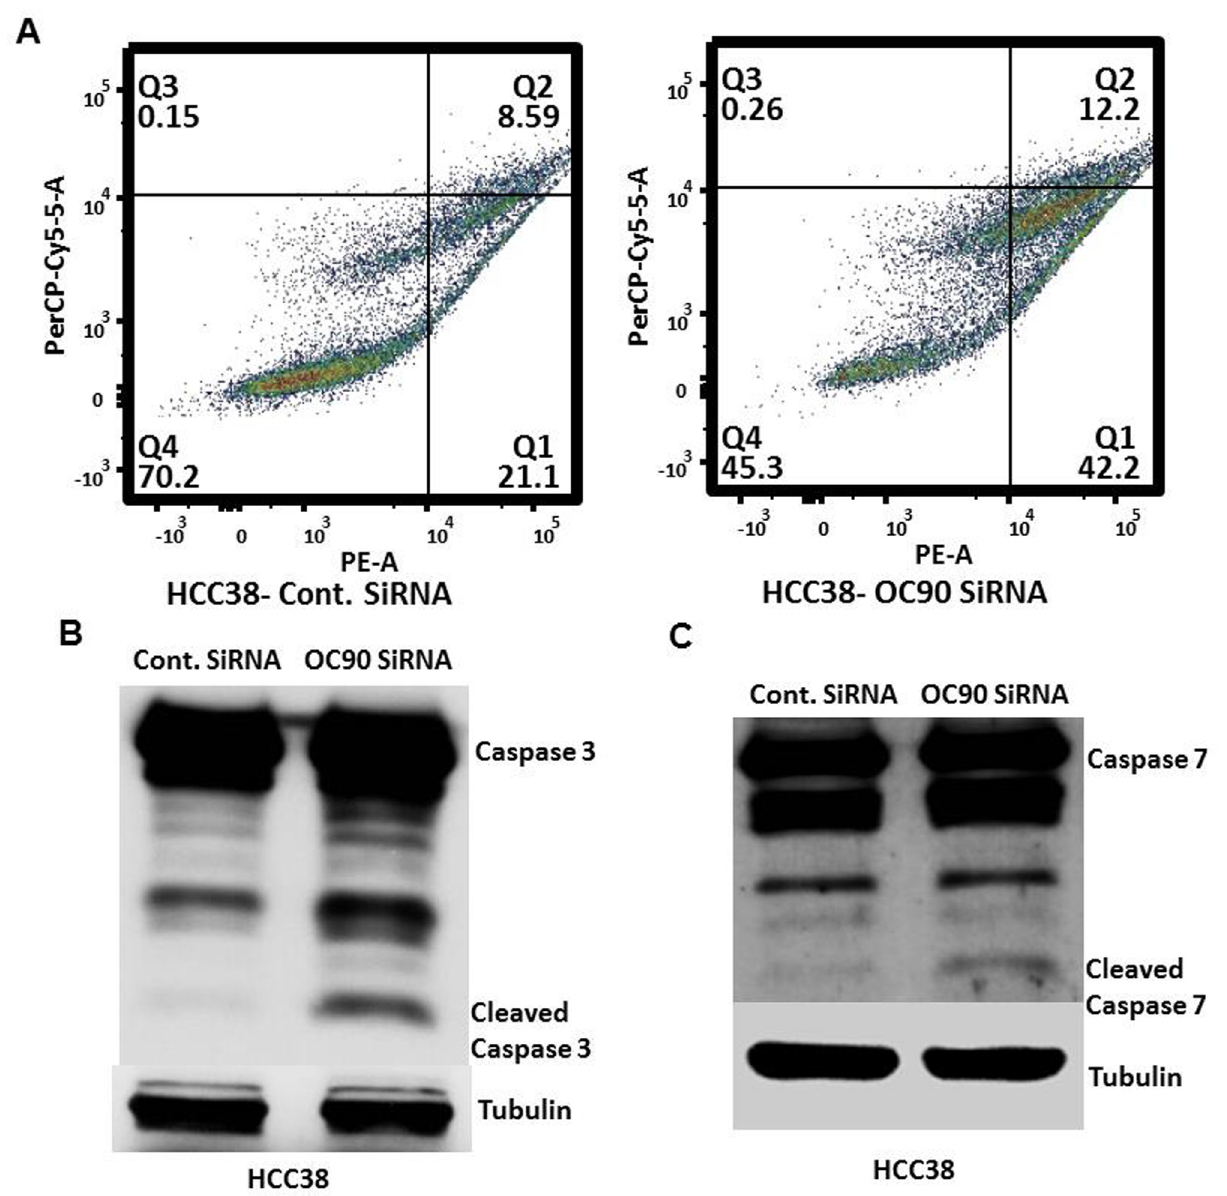
Fig 4. OC90 siRNA treatment promotes apoptosis in HCC38 cells. A) Flow cytometry graphs showing distribution of HCC38 cells based on Annexin V (PE, X-axis) and 7-AAD (PerCP-Cy5.5, Y-axis) intensity 72 hours after control siRNA or OC90 siRNA treatment. B) & C) Western blot showing increase in cleaved Caspase 3 & 7 (respectively) in HCC38 cell line after OC90 knockdown. Based on these findings, significant reduction in cellular viability in TNBC cell lines after OC90 knockdown may be due to its function as an anti-apoptotic gene in TNBC and may also have some role in cellular